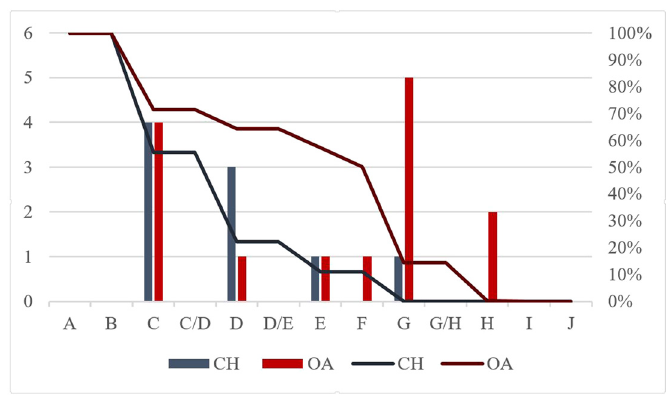
Figure 3: Racot 18. Kill - o ff patterns for sheep ( OA ) and goats ( CH ) based on caprine mandibles. The left column – a number of mandibles; the right column – % age survivorship ( after Wybult, 2019, Figure 6.1 )